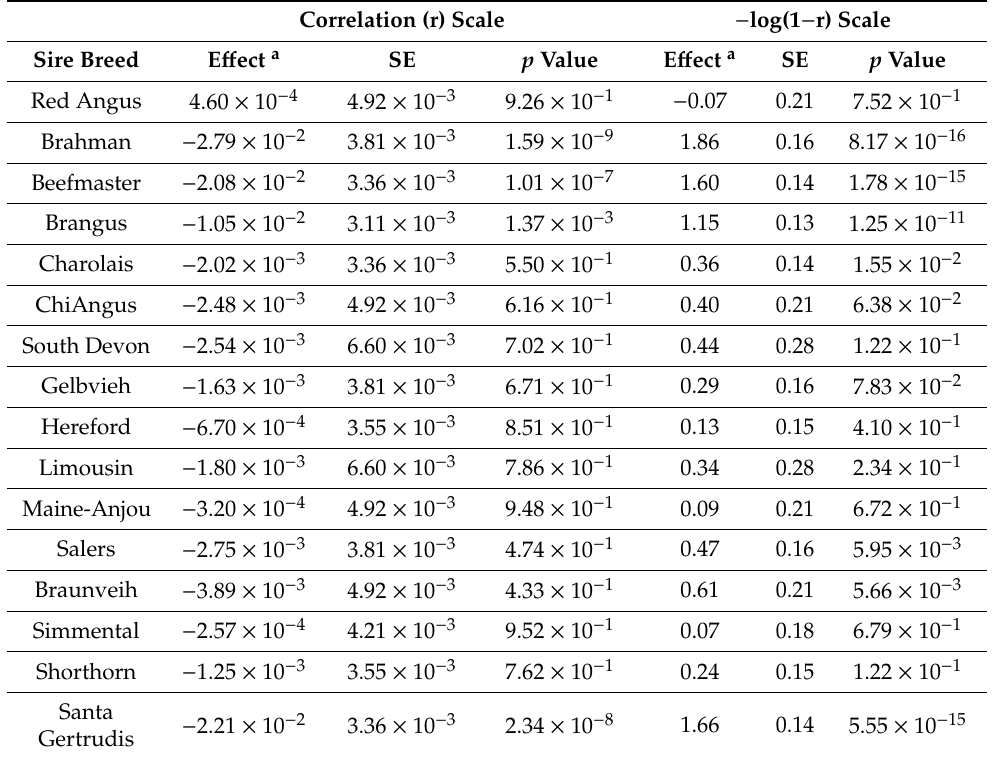
Table 3. Sire-breed di ff erences among correlations between genotypes imputed from downsampled sequence and called from transcript